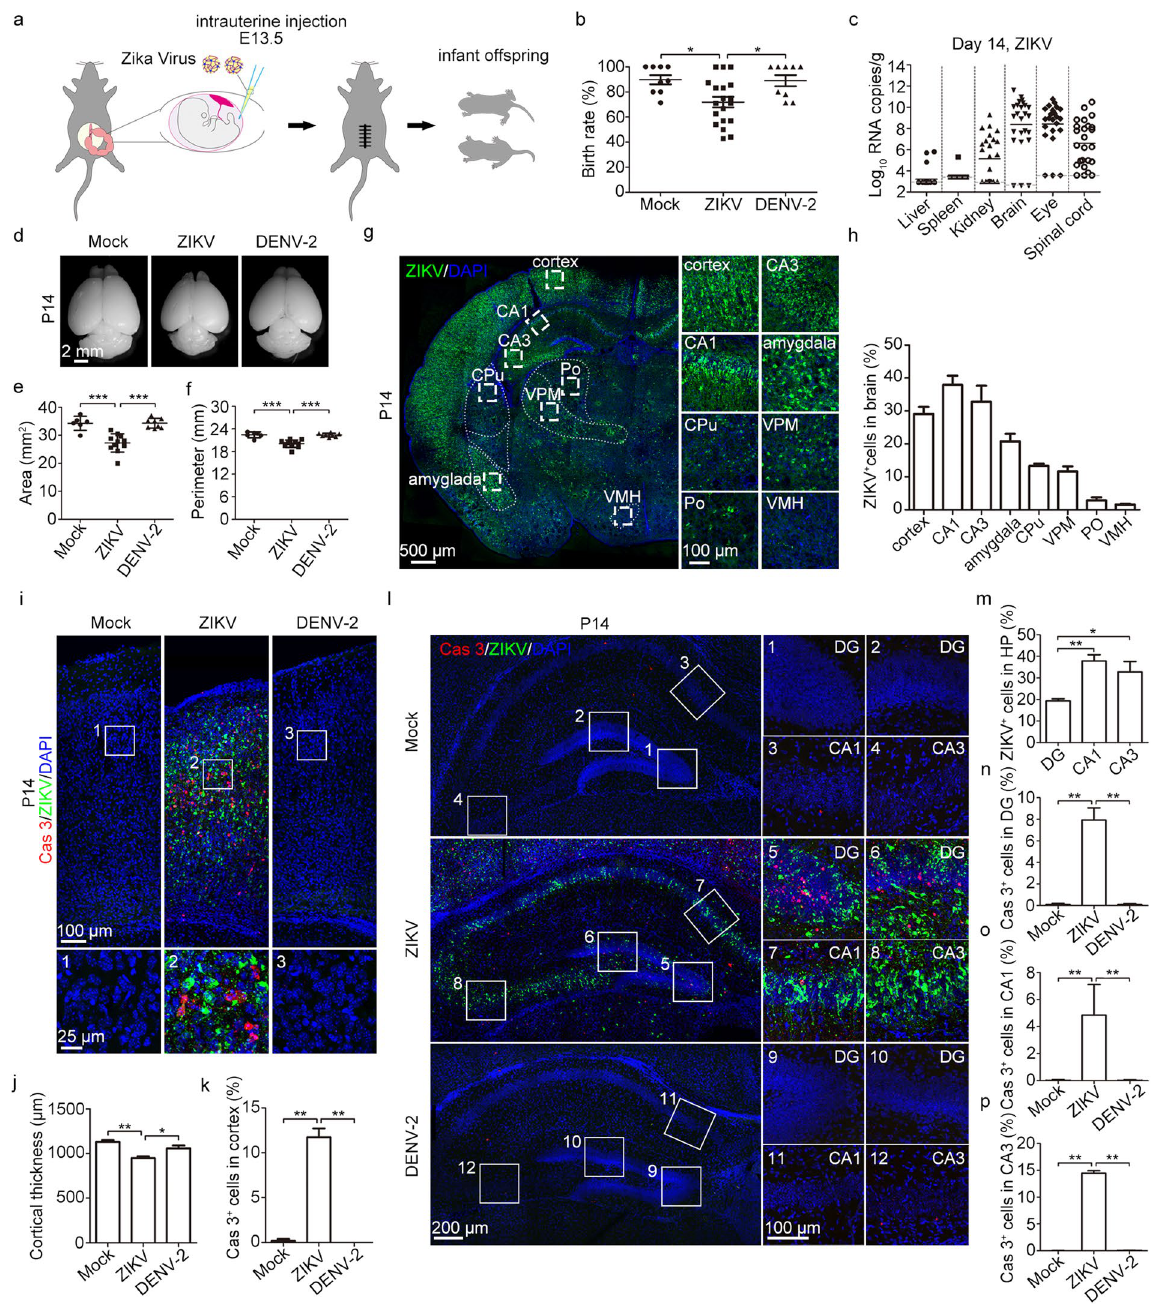
Figure 1. Low birth rate, high mortality and severe brain pathology induced by intrauterine ZIKV inoculation. (a) Schematic depiction of intrauterine inoculation during pregnancy. Offspring mice were used in following studies. (b) Birth rate of neonatal mice. (c) ZIKV viral load in P14 tissues was measured by qRT-PCR. Bars indicate the mean. The gray dashed lines indicate the limit of detection. (d) Representative images of brains from P14 offspring. (e,f) Area (e) and perimeter (f) of the hemiencephalon of P14 mice. (g) Overview of ZIKV infection in 1 representative brain slice. CPu, caudate putamen (striatum); Po, posterior thalamic nuclear group; VPM, ventral posteromedial thalamic nucleus; VMH, ventromedial hypothalamic nucleus. (h) Percentage of ZIKV-infected cells in different brain regions. n = 5 samples from three independent experiments. (i) Representative images of the cortex stained for Cas3 (Caspase 3) and ZIKV. (j) Quantification of cortical thickness. (k) Percentage of Cas3-positive cells within the cortex. (j,k) n = 5 samples from three independent experiments. (l) Representative images of the hippocampus stained for Cas3 and ZIKV. (m) Percentage of ZIKV-infected cells in the DG, CA1, and CA3. n = 5 samples from three independent experiments. (n – p) Percentage of Cas3-positive cells within the DG(n), CA1(o), and CA3(p), respectively. n Mock = 4, n ZIKV = 5, n DENV-2 = 4 samples from three independent experiments. Quantification data are presented as the mean ± SEM. One-way ANOVA with Bonferroni’s post hoc test ( * p < 0.05, ** p < 0.01, *** p <